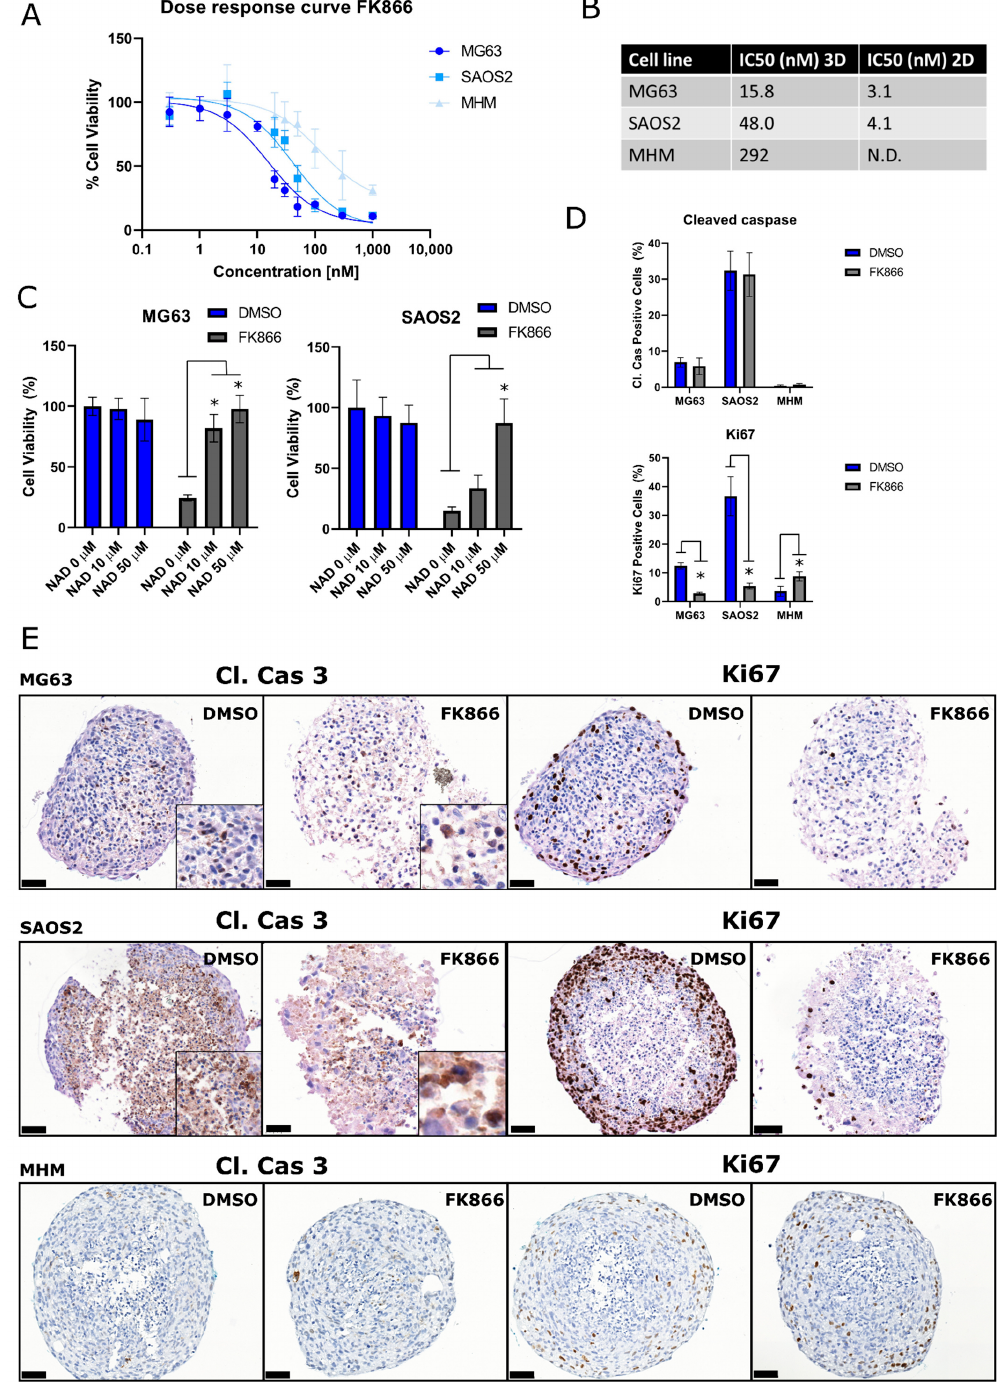
Figure 3. The NAMPT inhibitor FK866 decreases cell viability in 3D cultured osteosarcoma cell lines. ( A ) Osteosarcoma multi-cellular tumor spheroids were treated for 72 h with the NAMPT inhibitor FK866, after which relative cell viability